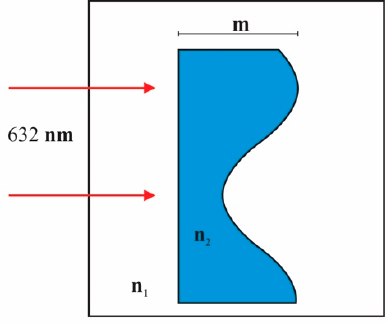
Figure 11. Sinusoidal grating profile.